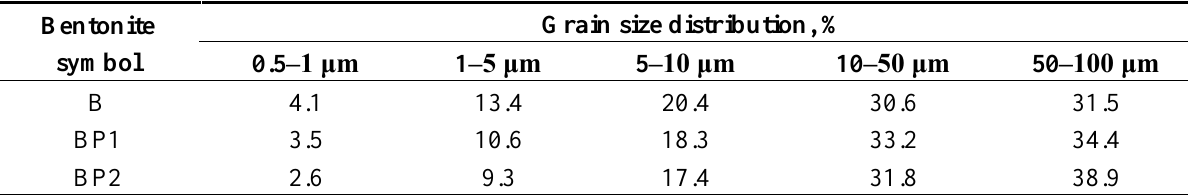
Table 3. Summary of results for particle size distribution of bentonite, unmodified and modified with POSS1 and